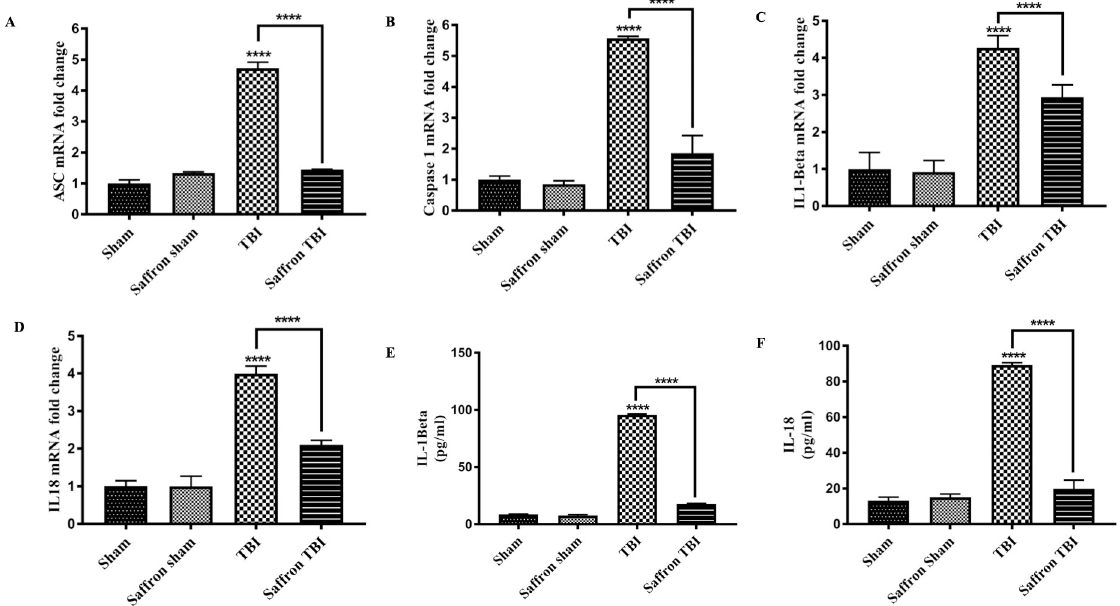
Fig 5. Effect of saffron extract on ASC, caspase 1, IL-1 β , and IL-18 levels. (A), (B), (C), and (D) show mRNA fold–changes of ASC, caspase1, IL-1 β , and IL-18 genes respectively. (E) and (F) show IL-1 β and IL-18 levels in cortex homogenate respectively. Data are mean ± SEM of 9 mice per group. ( ���� ) represent P <